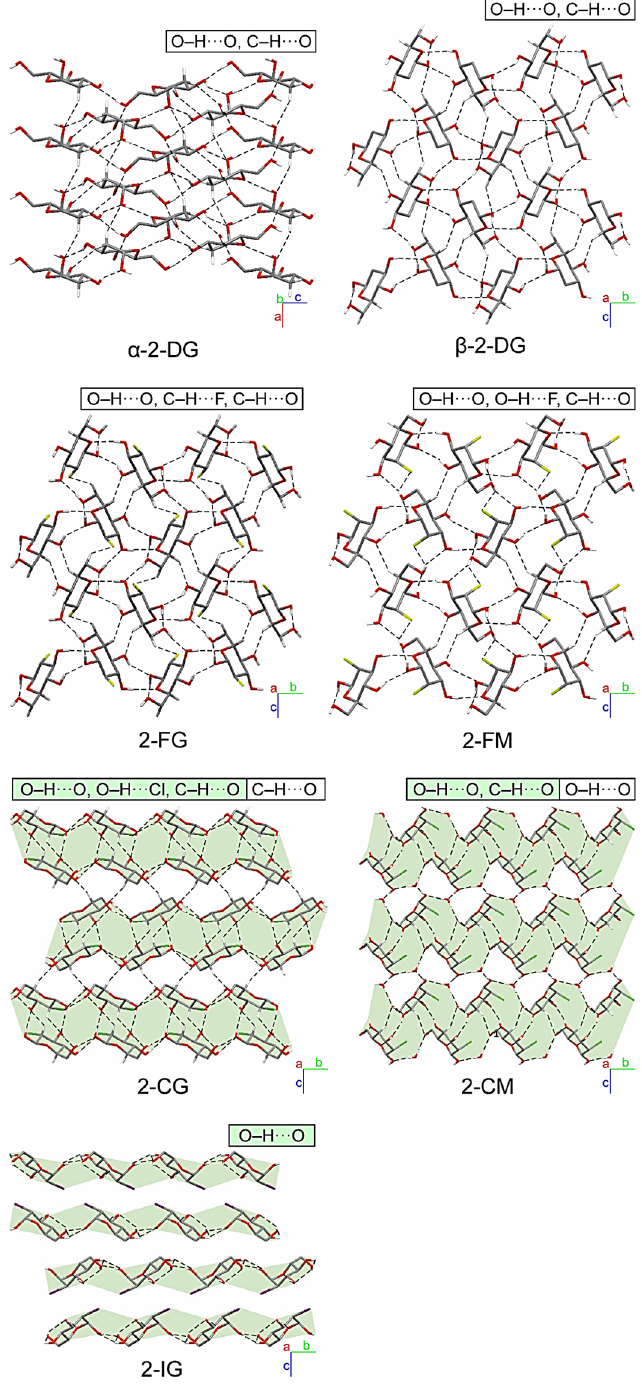
Figure 4. Comparison of packing of molecules in the crystals of investigated halogenated derivatives of glucose and mannose, and the α - and β -anomers of their parent compound. Hydrogen bonds are represented by the dashed lines. The H-atoms not participating in intermolecular hydrogen bonds have been omitted for the sake of clarity. Layered entities have been highlighted in light-green.